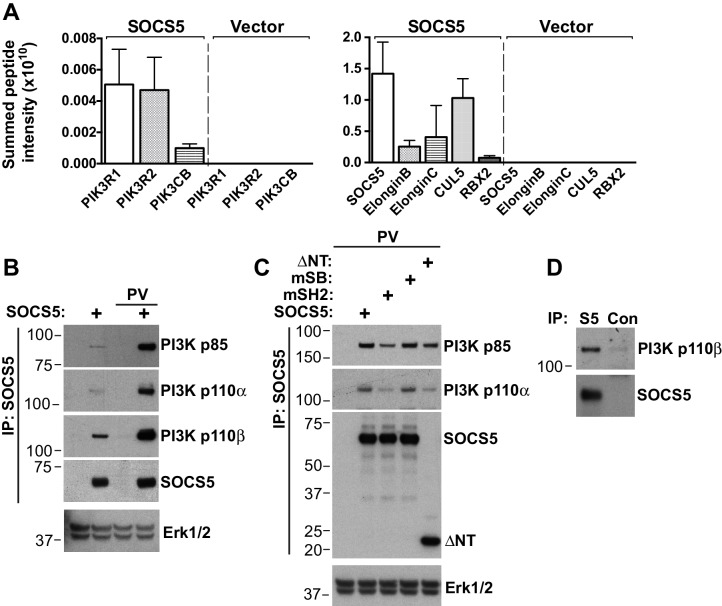
SOCS5 interacts with a PI3K complex.(A–C) 293T cells were transiently transfected with constructs expressing Flag-tagged SOCS5, SOCS5 mutants or vector alone, lysed and SOCS5-containing complexes immunoprecipitated (IP) using anti-Flag antibodies. (A) Protein complexes were analyzed by tryptic digest and mass spectrometry. Mean ± S.D. of summed peptide intensities from three replicates. The PI3K components, and SOCS5 and SOCS box components, were specifically enriched relative to immunoprecipitates from cells transfected with vector alone. (B,C) SOCS5-containing protein complexes were analyzed by immunoblotting with the indicated antibodies. Lysates were probed with antibodies to Erk1/2 to show equal protein input (lower panels). PV indicates pre-treatment of cells with pervanadate to inhibit phosphatase activity. mSH2: SOCS5-R406K; mSB: SOCS5-L484P, C488F; ΔNT: residues 350–536. (D) A549 cells were pre-treated with the proteasomal inhibitor MG132 (6 h) and pervandate (20 min) prior to lysis. Proteins were immunoprecipitated with either isotype control antibodies (Con) or SOCS5-specific antibodies (S5) and analyzed by immunoblotting with the indicated antibodies.